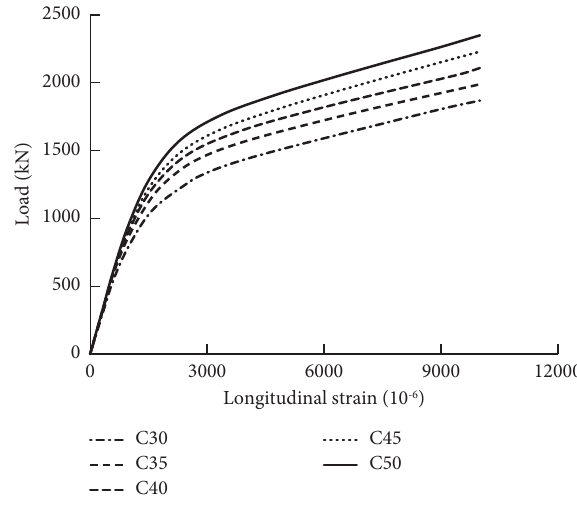
Figure 13: Te infuence of strength